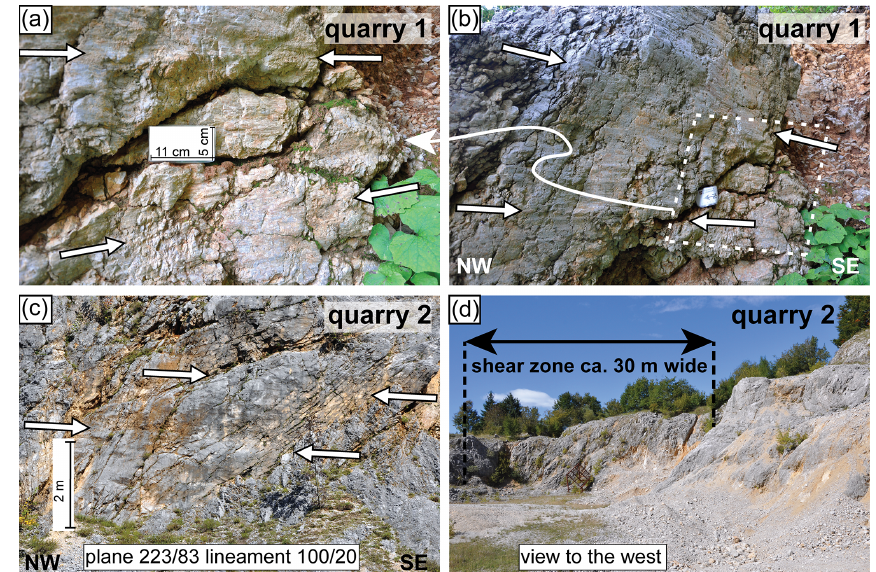
Figure 5. Quarries along the Predjama Fault; see Fig. 2 for location. Both quarries exhibit Jurassic coralliferous limestones. (a) At the southern strand of the fault, quarry 1 (46.0299 ◦ N, 13.7632 ◦ E) exhibits E–W lineaments with right-lateral shear sense on a fault plane dipping steeply to the southwest. (b) Larger section of the striated surface in quarry 1. (c) Large SW-dipping fault planes are present at the northern fault strand in quarry 2 (46.0506 ◦ N, 13.7485 ◦ E). Slickensides show almost horizontal right-lateral motion. (d) In quarry 2, the shear zone is ca. 30m